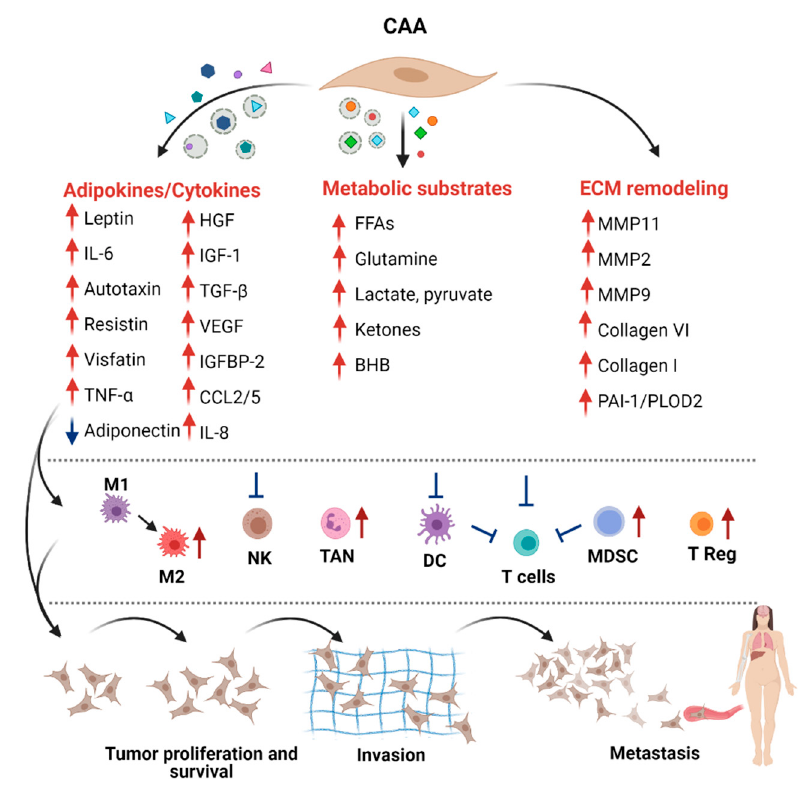
Figure 4. Pro-tumoral factors released by cancer-associated adipocytes (CAAs). CAAs release free or exosome-associated molecules that directly or indirectly, through the modulation of the immune cells, induce the acquisition of aggressive features in breast cancer (BC) cells. The blue and red arrows indicate the increased and decreased release compared to mature adipocytes. In the central panel, blue lines indicate that cells are blocked in their function; red arrows indicate that cells are recruited/activated. BHB, β -hydroxybutyrate; DC, dendritic cells; FFAs, free fatty acids; IL, interleukin; HGF, hepatocyte growth factor; IGF, insulin growth factor; IGFBP2, IGF binding protein 2; M, macrophages; MDSC, myeloid derived suppressor cells; NK, natural killer cells; PAI-1, plasminogen activator inhibitor 1; PLOD2, procollagen-lysine 2-oxoglutarate 5-dioxygenase 2; TGF β , transforming growth factor β ; TAN, tumor associated neutrophils; TNF, tumor necrosis factor; T Reg, regulatory T cells; VEGF, vascular endothelial growth